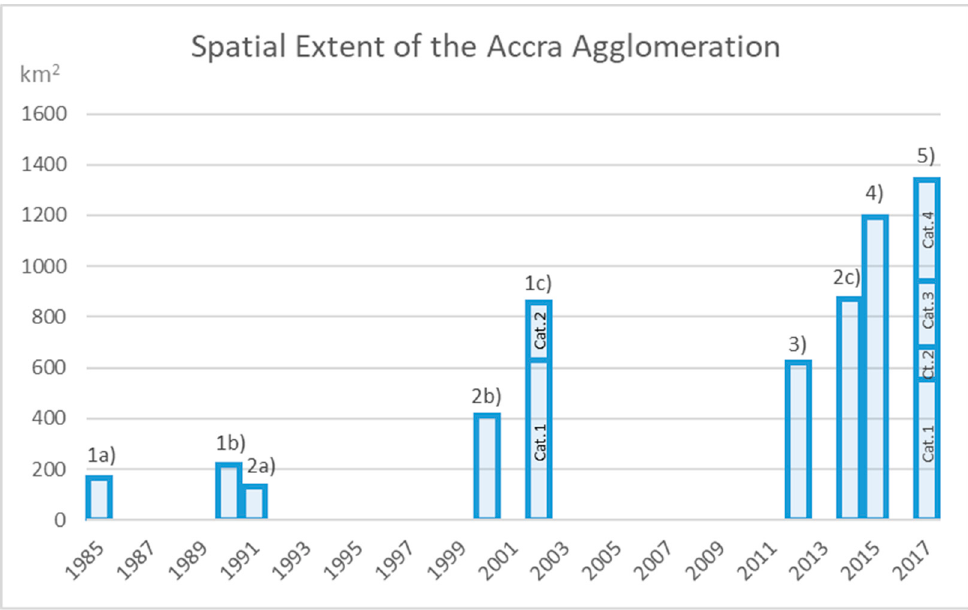
Figure 2. Area figures for the Accra agglomeration reported by five different studies. (1a), (1b), (1c) Landsat-TM texture [26], 1985 and 1991. (1c) Landsat-TM texture 2002, Category 1: “urbanized areas” and Category 2: “areas under conversion”. (2a), (2b), (2c) Atlas of Urban Expansion [12], 1991, 2000 and 2014. (3) Global Urban Footprint [27], 2012. (4) AfricaPolis [28], 2015. (5) Visual inspection of segments (prepared for this study), 2017. Category 1: “full urbanization”, Category 2: